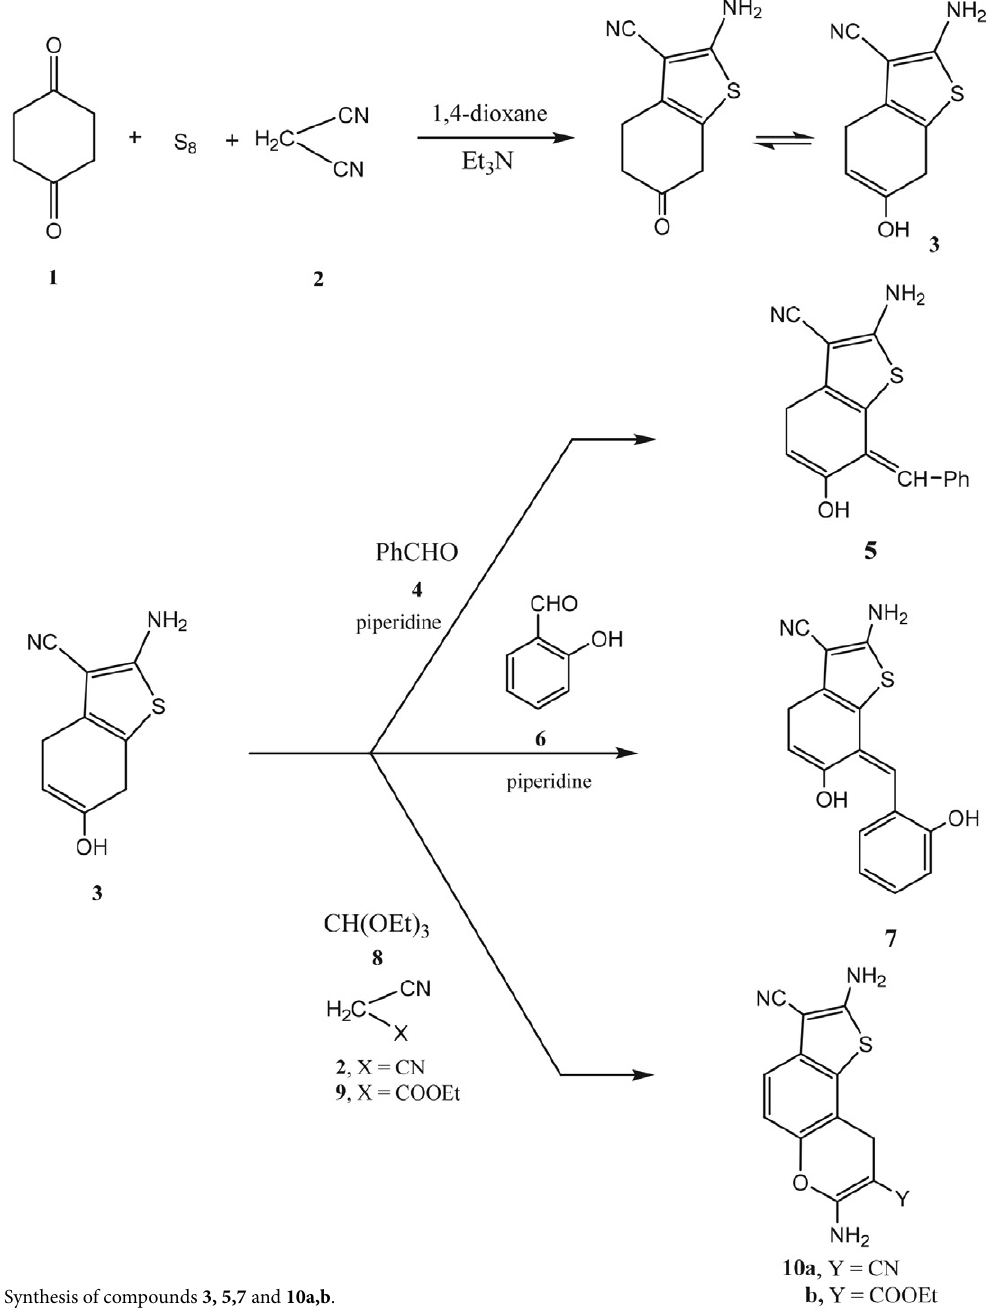
Schema 1: Synthesis of compounds 3, 5,7 and 10a,b